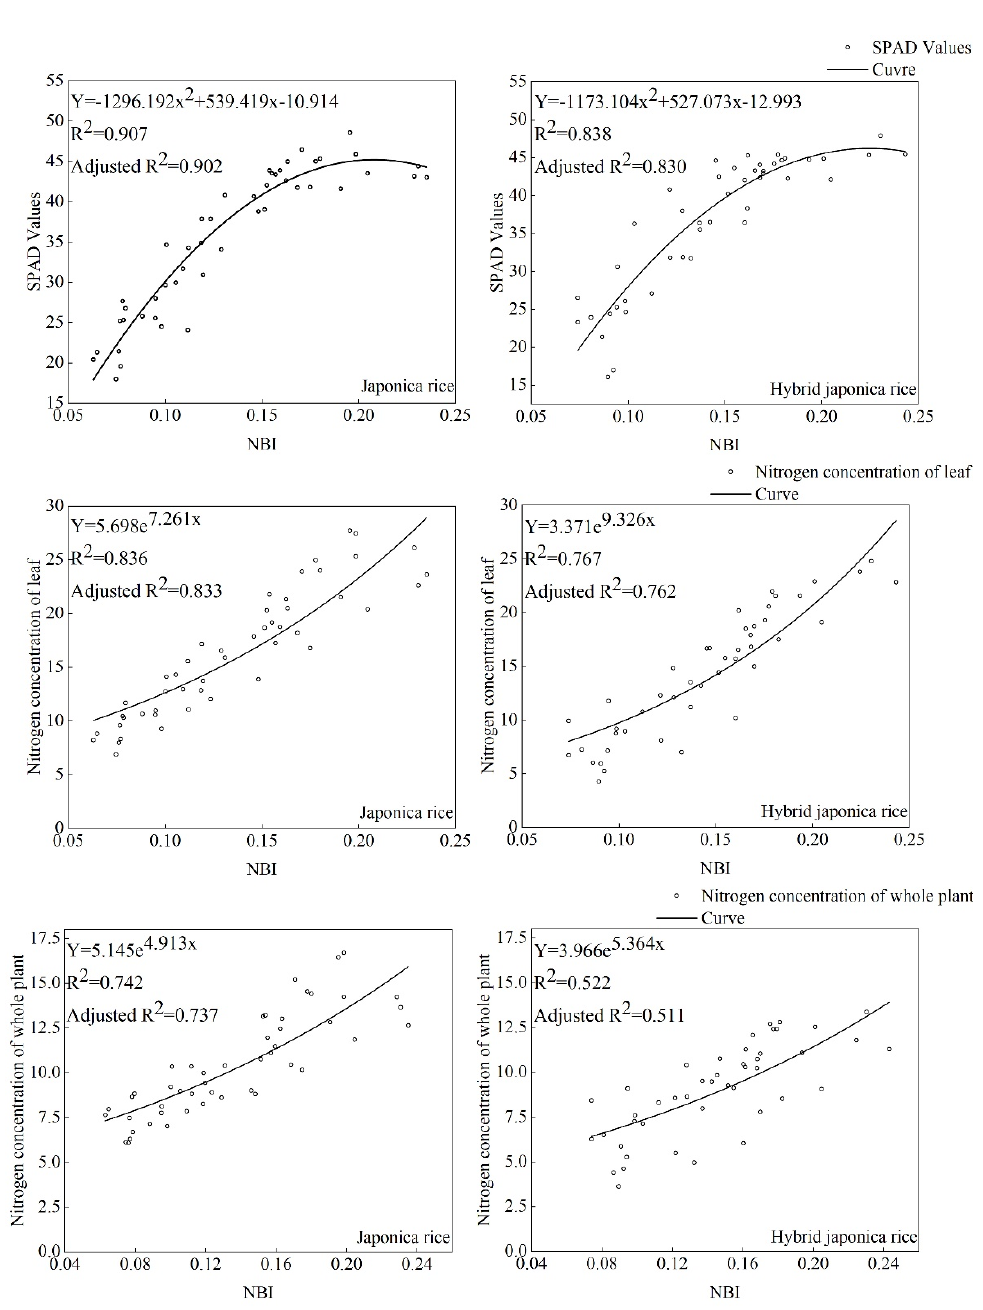
Figure 13. Curves for nitrogen, targets, and NBI for rice leaves after